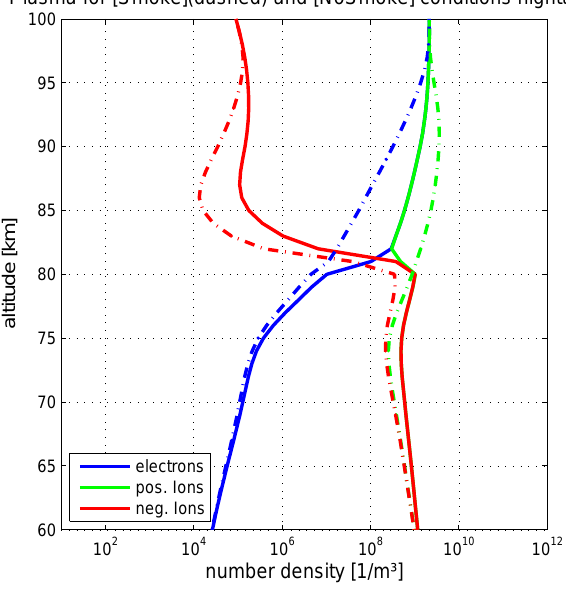
Fig. 9. Height profiles of the plasma densities, for a model run with MSP (dashed lines) and without MSP (solid